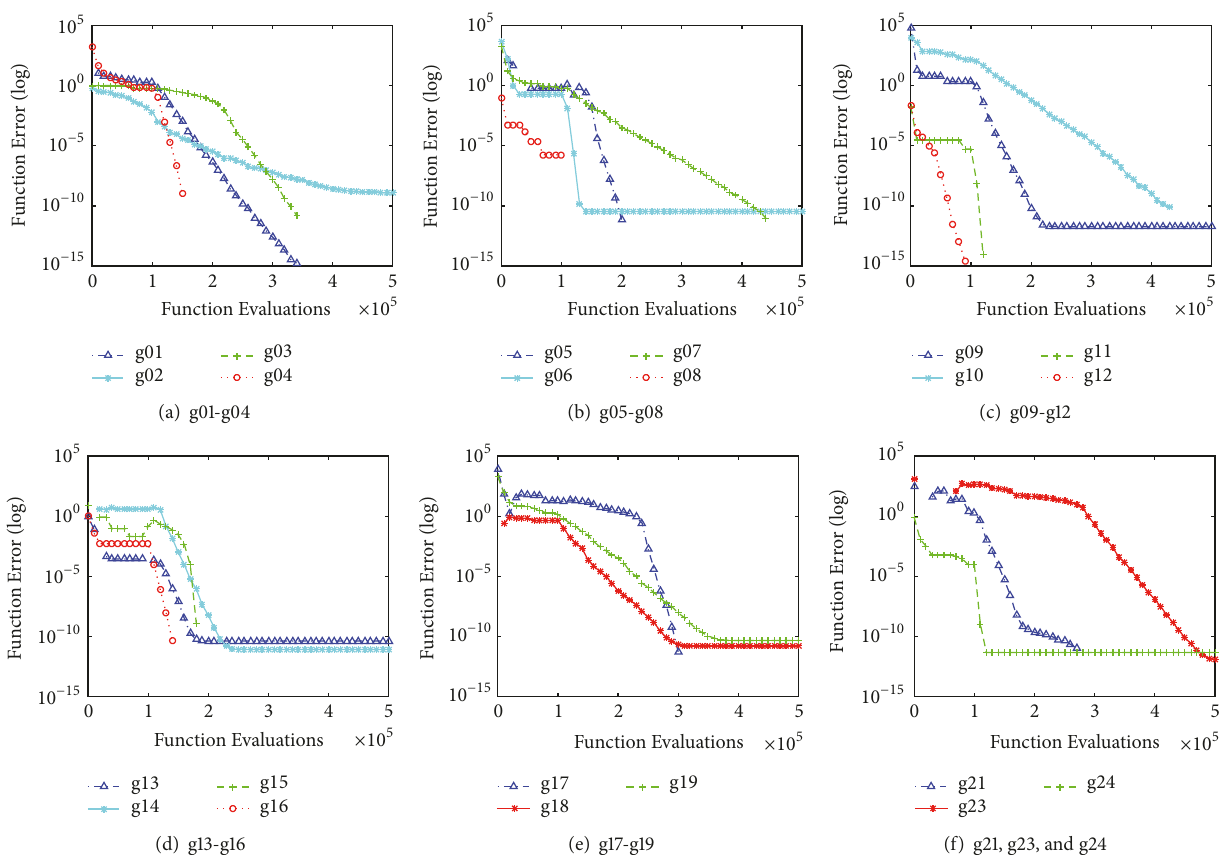
Figure 4: Convergence curves for general performance in terms of function error values obtained by CADE for the benchmarktest instances except g20 and